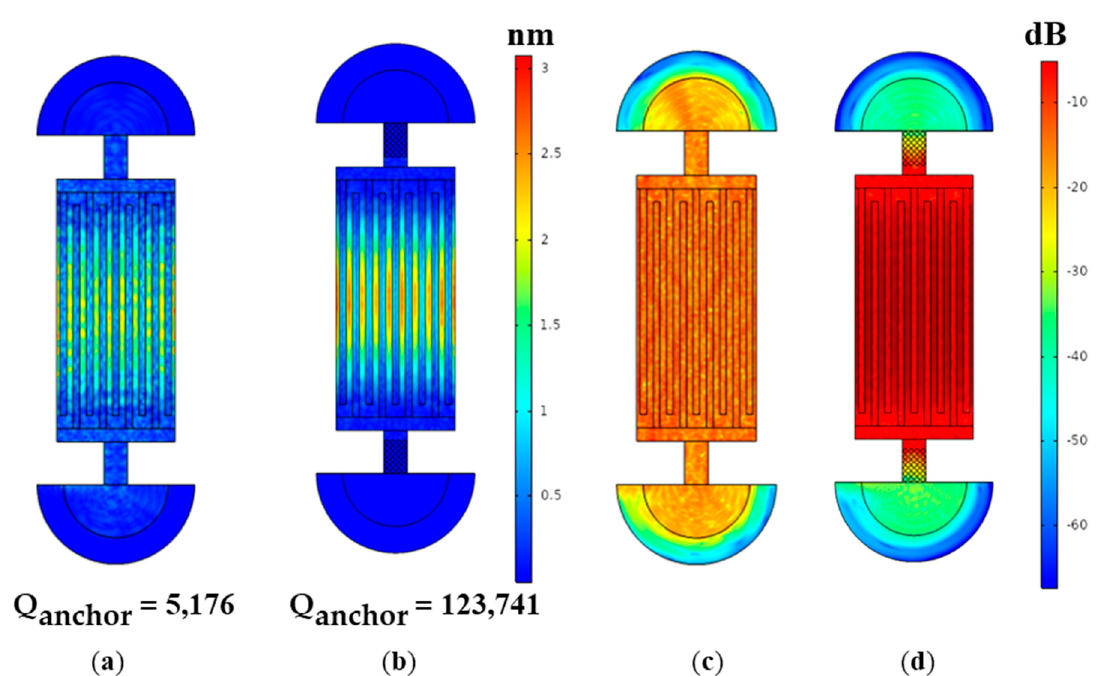
Figure 8. The displacement distribution of the LWR with ( a ) uniform beam anchors and ( b ) PnC slab anchors. The nor- malized logarithmic displacement distribution of the LWR with ( c ) uniform beam anchors and ( d ) PnC slab anchors.